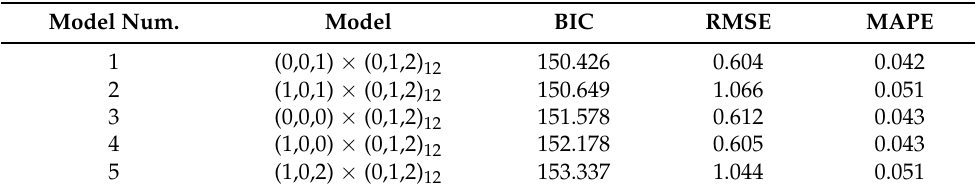
Table 1. Estimated BIC values of different ARIMA models fitted to the data.